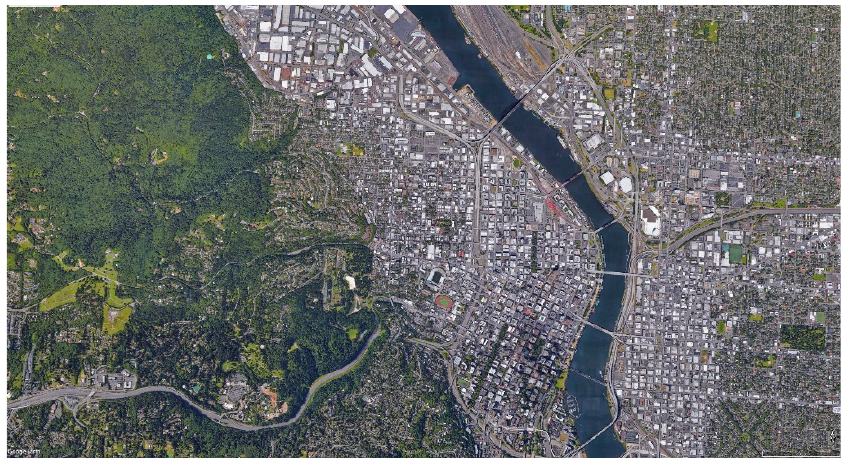
Figure 3. Downtown Portland (OR, USA). The contrast between the nature and the city. Image from Google Earth.